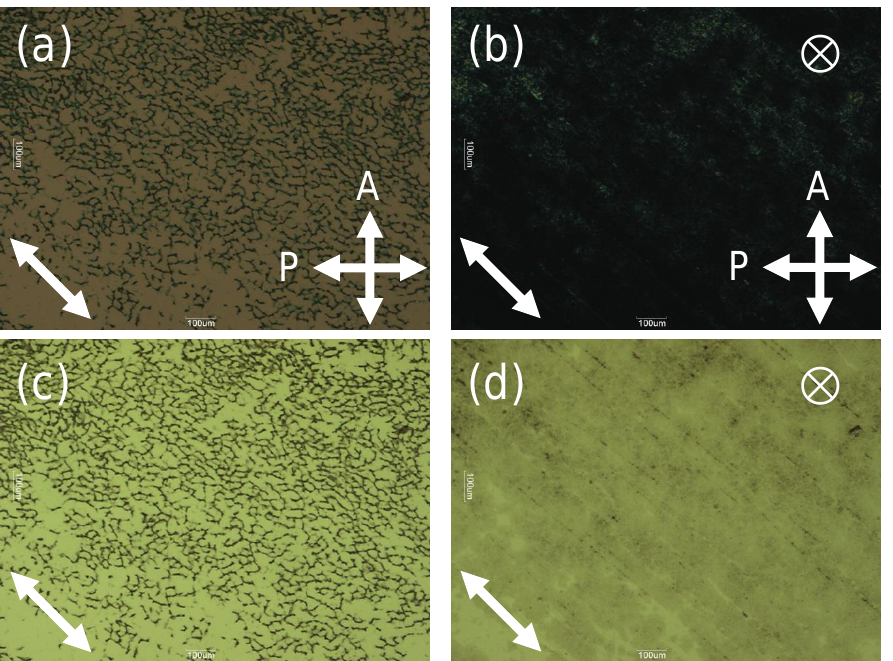
Figure 9. ( a , b ) Cross Nicol and ( c , d ) open Nicol images of GNP-C6-LC (10 wt%) in 7CT at 58 ◦ C. The images were taken under ( a , c ) 0 kV mm − 1 and ( b , d ) 3 kV mm − 1 .